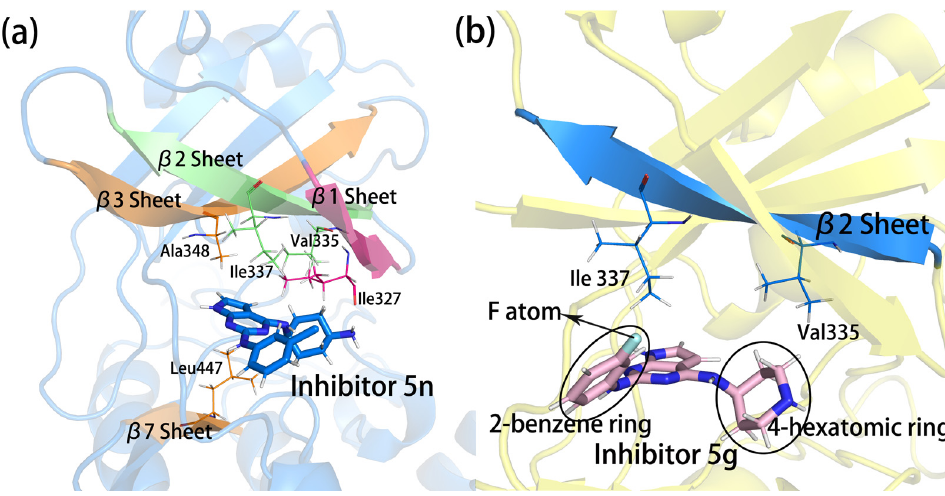
Figure 9. The positions of residues on the β -sheets in relation to the inhibitors. ( a ) Residues on the β -sheets with strong interactions with the inhibitors; ( b ) position relationships of Val335 and Ile337 with the 2-benzene ring and 4-hexamoric ring.